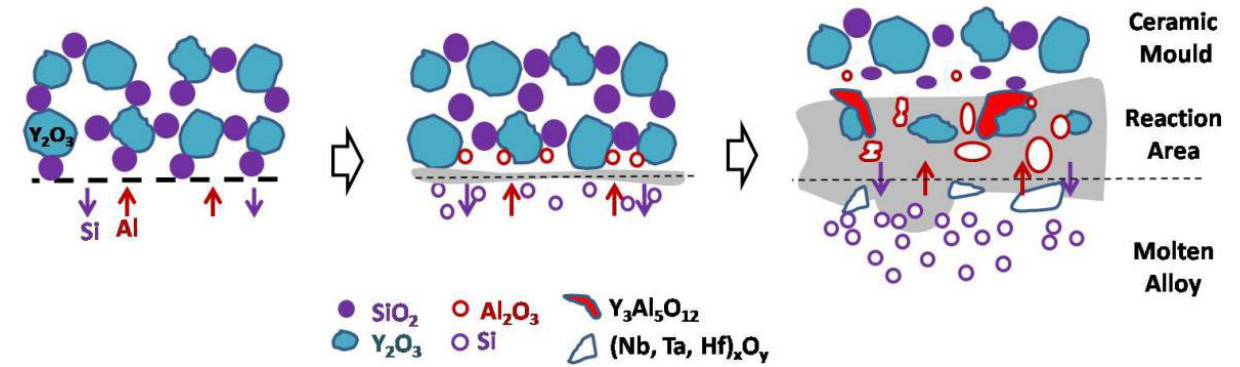
Figure 10. The inter-diffusion mechanism of reaction layer.